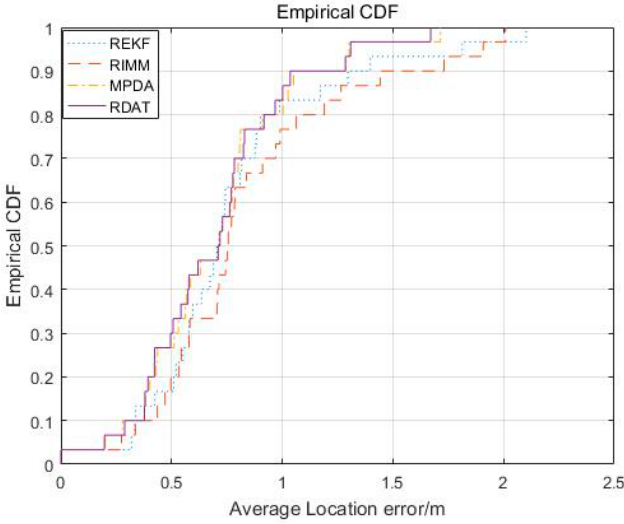
Figure 13. The CDF result of localization error.